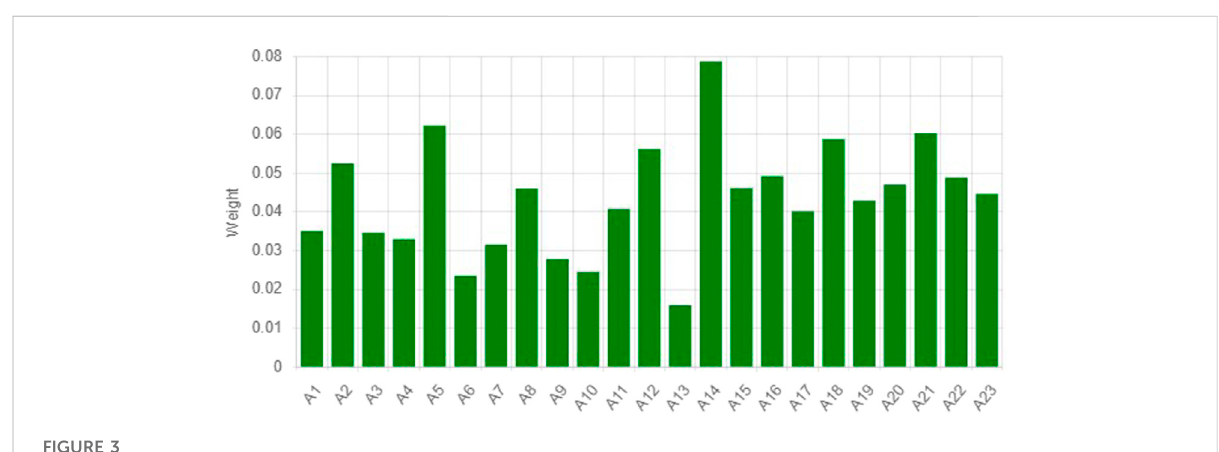
FIGURE 3 The ranking of